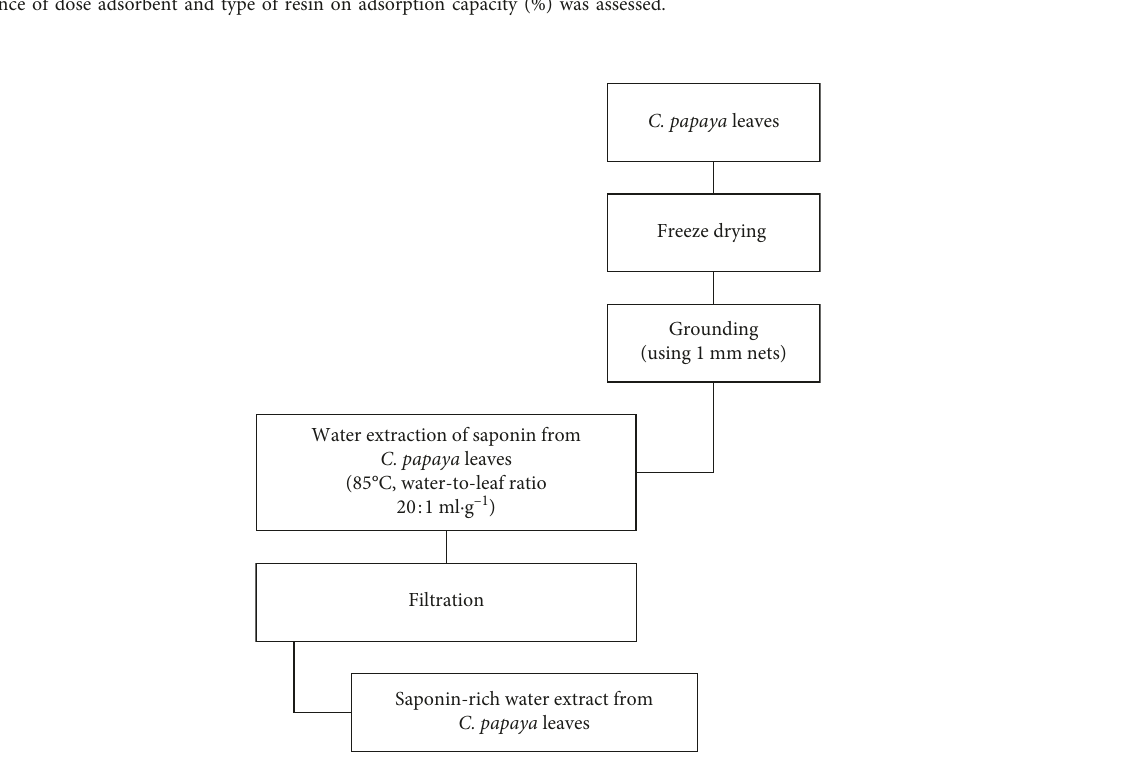
Figure 1: Preparation of saponin-enriched water extracts from C. papaya